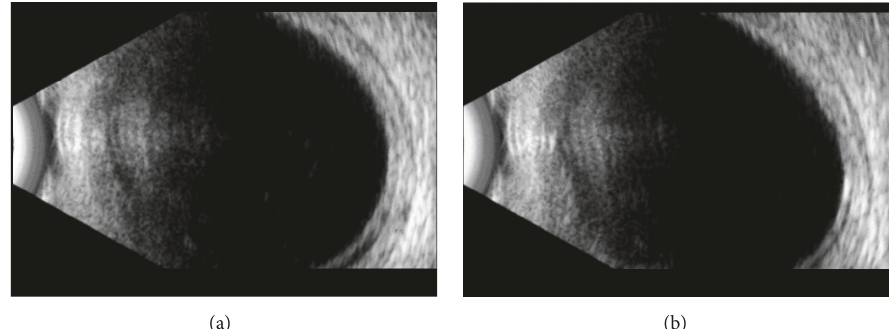
Figure 3: Mode B ultrasonography showing choroidal effusion at diagnosis ((a) right eye; (b) left